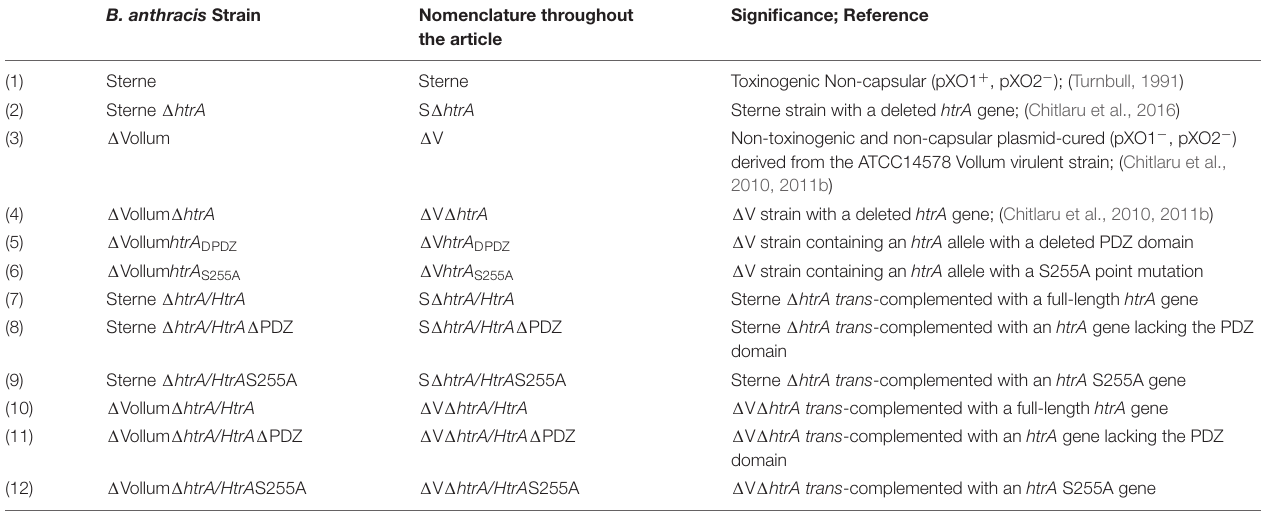
TABLE 1 | Bacillus anthracis strains used in the present